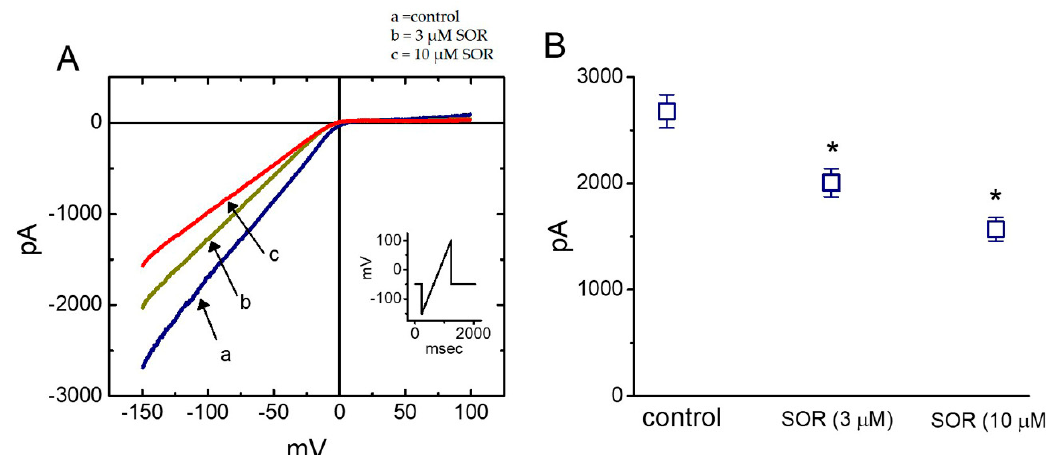
Figure 4. Inhibitory effect of SOR on inwardly-rectifying K + current ( I K(IR) ) in neonatal rat ventricular myocytes (NRVMs). ( A ) Superimposed I K(IR) traces obtained during the control (a) and in the presence of 3 μ M SOR (b) and 10 μ M SOR (c). Inset indicates the ramp voltage protocol used. ( B ) Bar graph showing the effect of SOR (3 and 10 μ M) on the I K(IR) amplitude measured at the level of − 150 mV ( n = 9). * Significantly different from the control, p < 0.05 by contrasts from one-way analysis of variance (ANOVA).